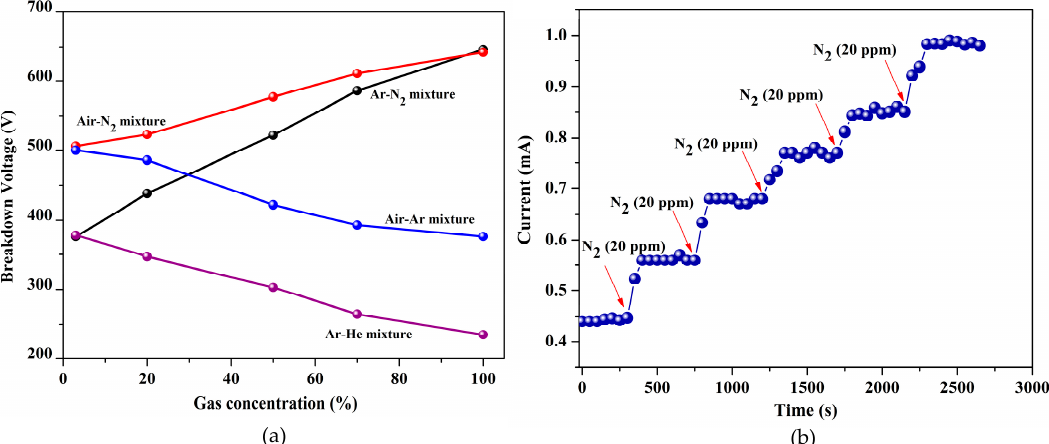
Figure 6. ( a ) Breakdown voltage variation with different gas-air mixtures. The breakdown voltage increased with increasing N 2 concentration and decreased with increasing Ar concentration, and ( b ) Dynamic sensing curves of the sensor for the air-N 2 mixture . The breakdown current increased as the relative concentration of N 2 increased in steps of 20 ppm.